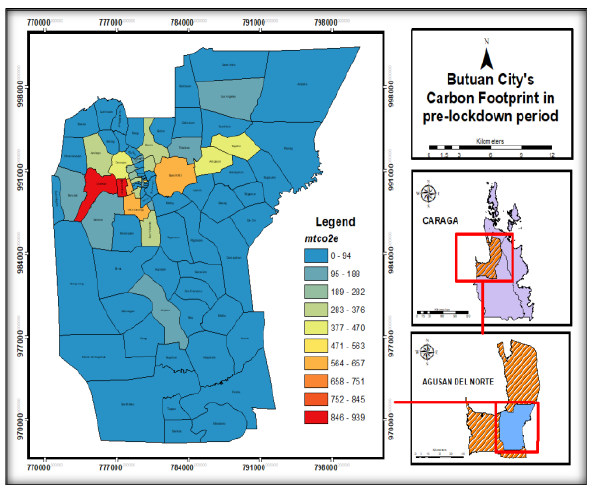
Figure 5. Spatial distribution of carbon footprint before COVID-19 lockdown (a month of January & February- 2020) in Butuan City.